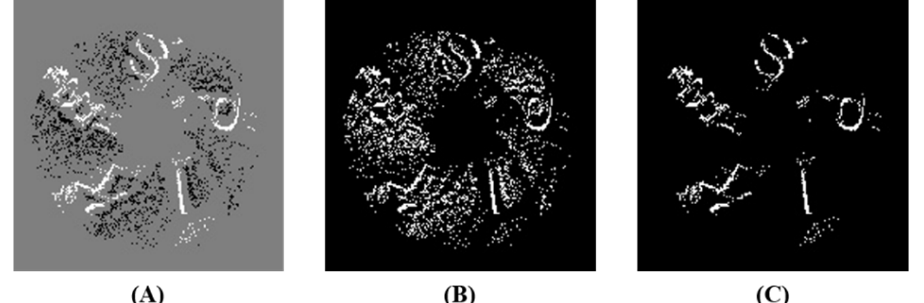
Figure 2. Visualization of event slices aggregated by different algorithms. ( A ) is accumulation aggregation; ( B ) is non-polarity aggregation; ( C ) is OR logic aggregation. Accumulation aggregation generates intensity images while OR logical aggregation results in binary images with much less noise than non-polarity aggregation.